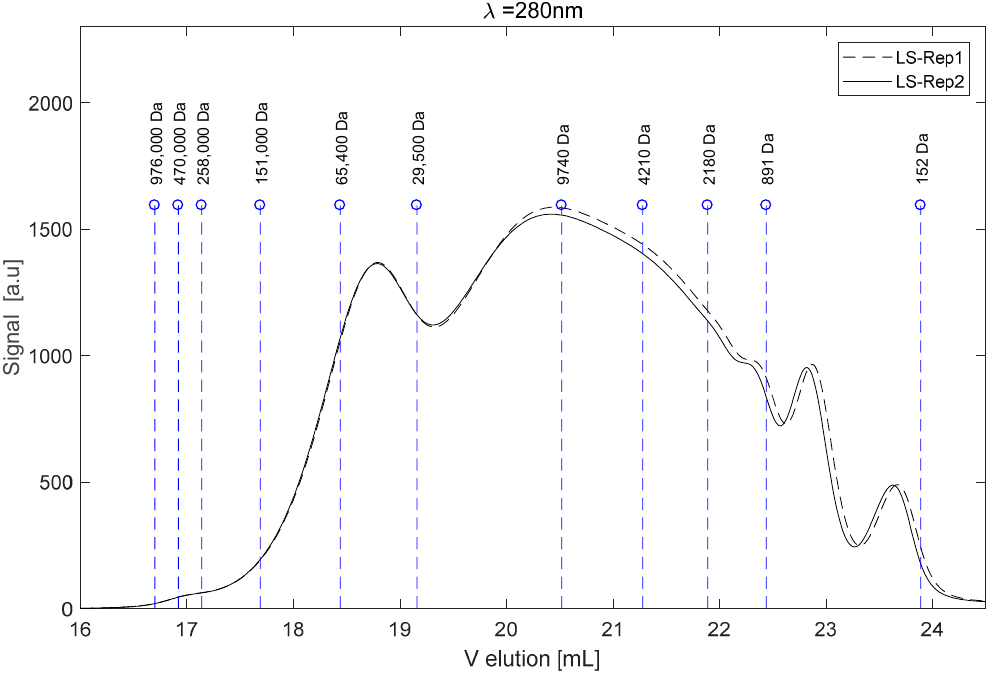
Figure 1. Eluogram of LS and peak elution volume of poly styrene sulfonate (PSS) calibrants.